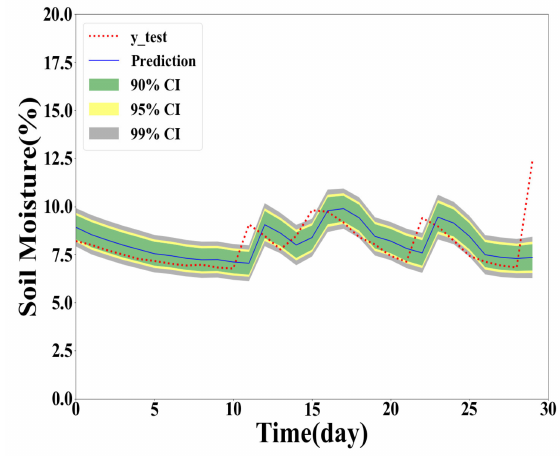
Figure 12. Y(1) prediction with the chosen training data and testing in test June.